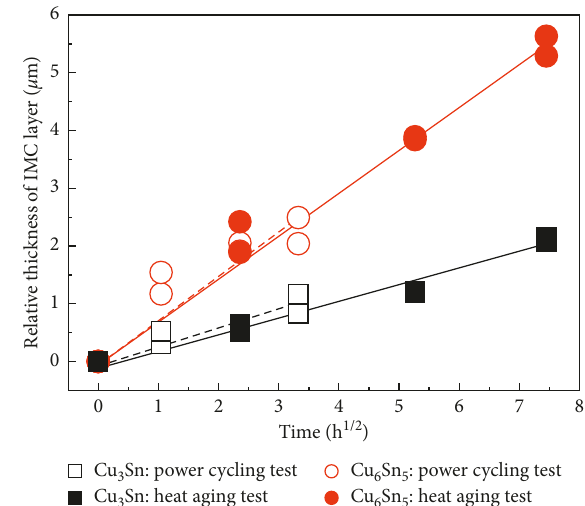
Figure 13: Thickness of IMC layers versus square root of heat aging time at 200 ° C.